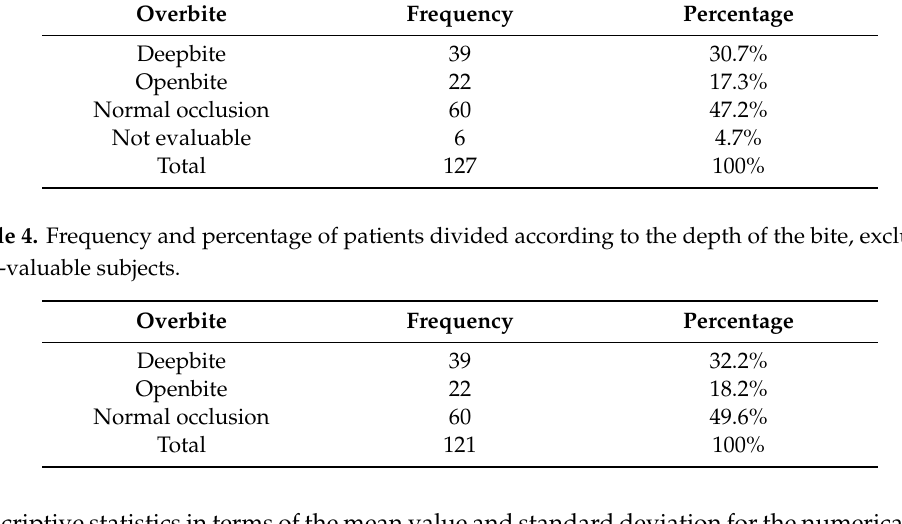
Table 3. Frequency and percentage of patients divided according to the depth of the bite. Overbite